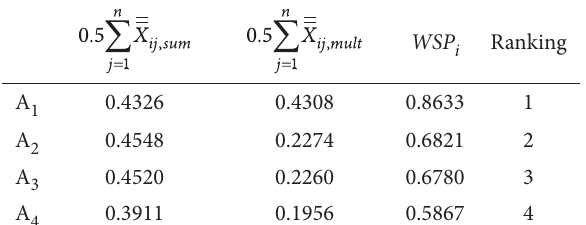
Table 8. The results of